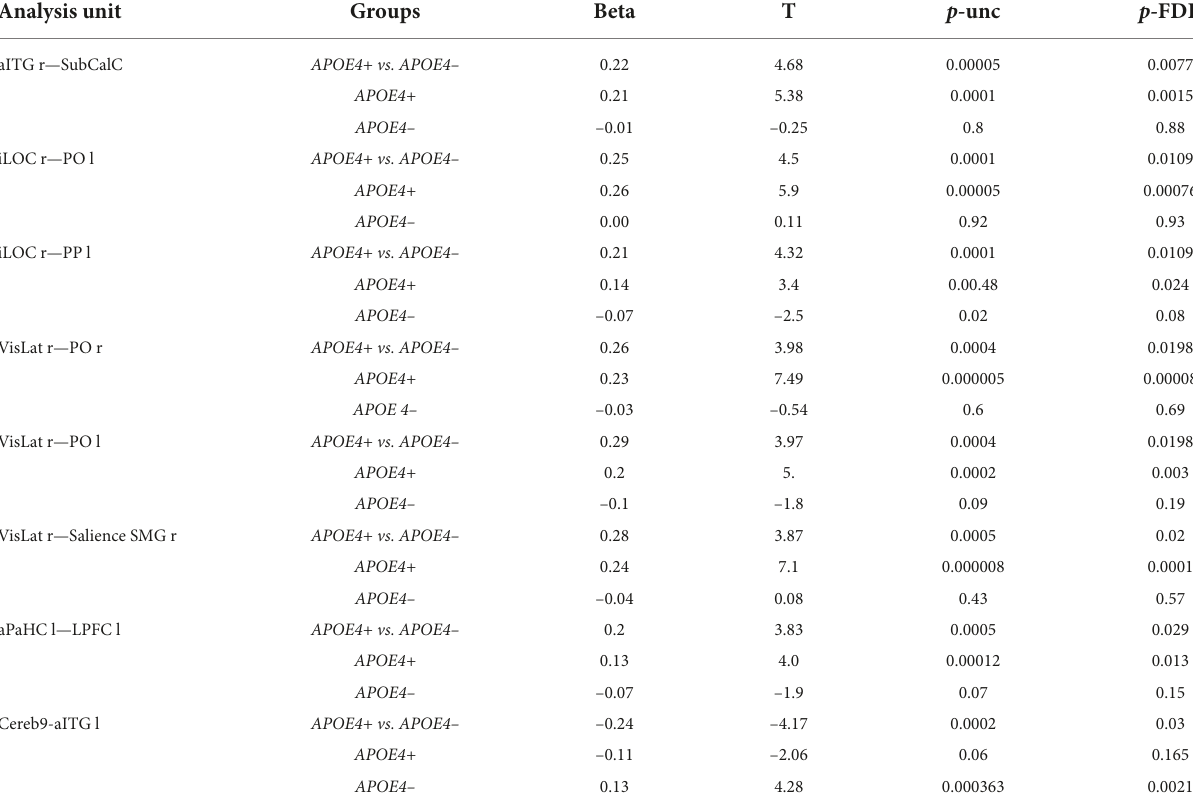
TABLE 3 ROI-to-ROI resting state functional connectivity (rsFC) according to fMRI of the APOE4+ and non-carriers. Analysis